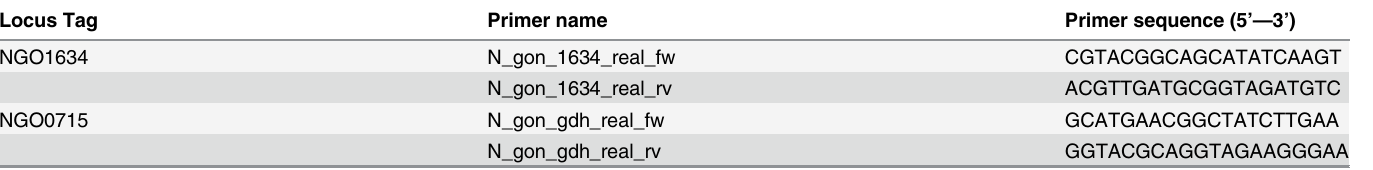
Table 3. Primers utilized for real-time